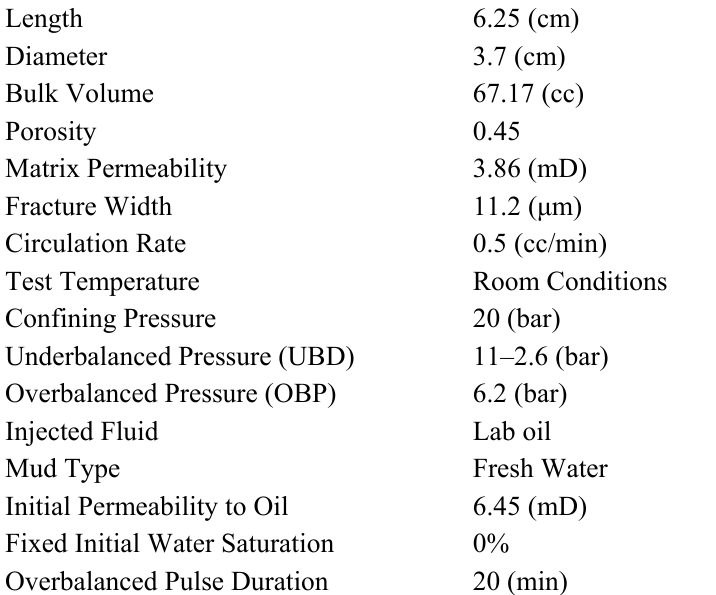
Table 8. UBD leak-off test with fresh water; on Sample